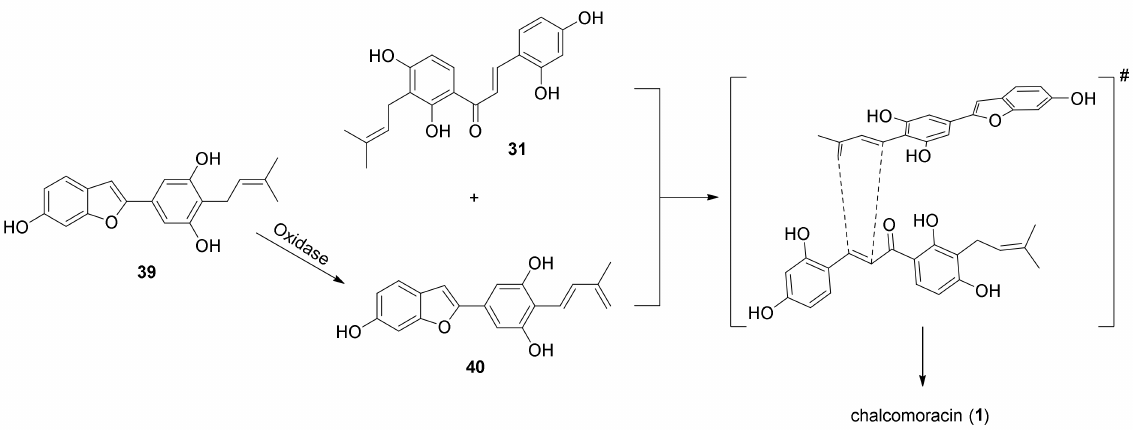
Figure 12. Proposed biosynthesis of chalcomoracin ( 1 ) from moracin C ( 39 ) and morachalcone A ( 31